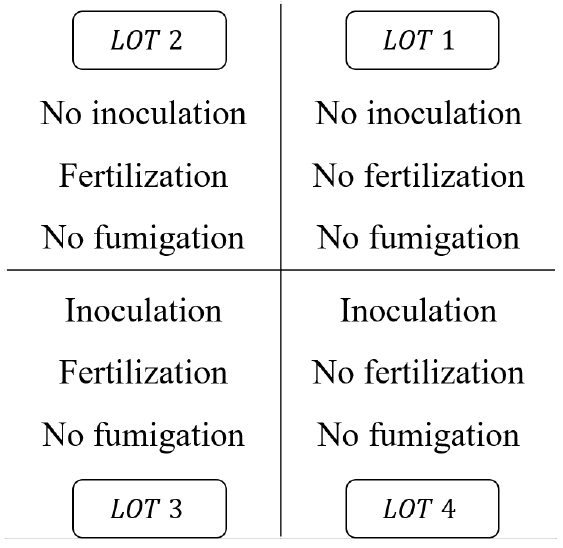
Figure 6. Data collection